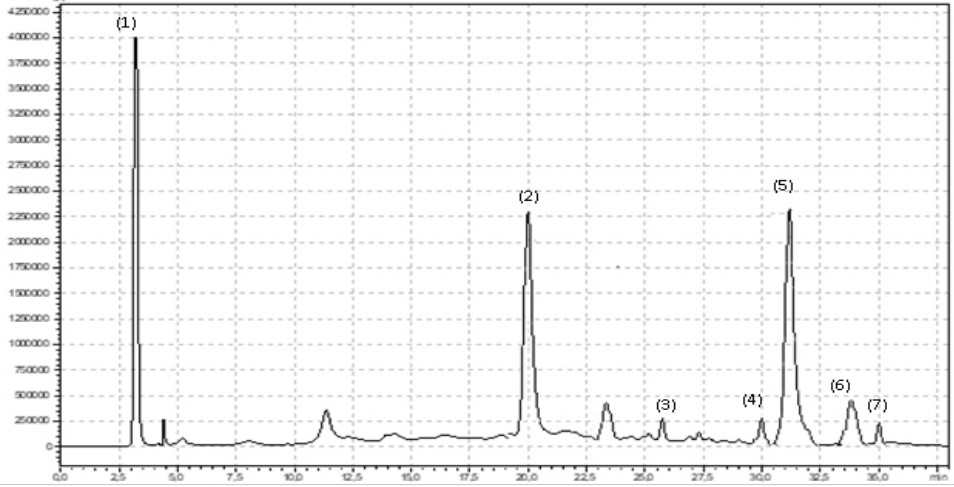
Figure 4. Chromatogram showing retention times for flavonoids in fireweed leaves: ( 1 ) oenothein B, ( 2 ) quercetin-3-O-rutinoside, ( 3 ) myricetin, ( 4 ) luteolin, ( 5 ) quercetin, ( 6 ) quercetin-3-O-glucoside, ( 7 ) kaempferol.